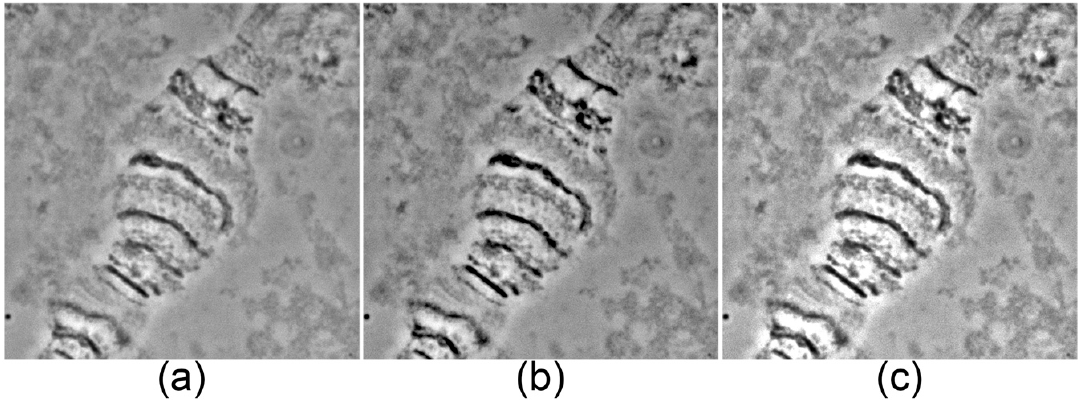
Figure 1. Levels of shadows and highlights in images of a 3R arm chromosome region of An. quadrimaculatus from ovarian nurse cells. ( a ) Appropriate levels of shadows and highlights; ( b ) over- shadowed levels; ( c ) over-highlighted